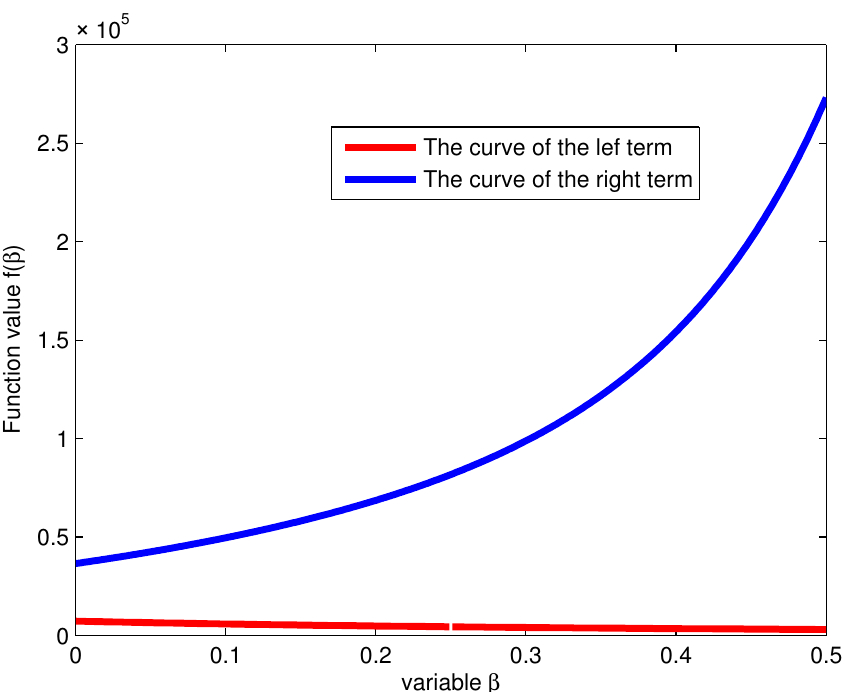
Figure 3. The image description of Corollary 4 for h ( t ) = t and g ( ξ ) = e 3 ξ